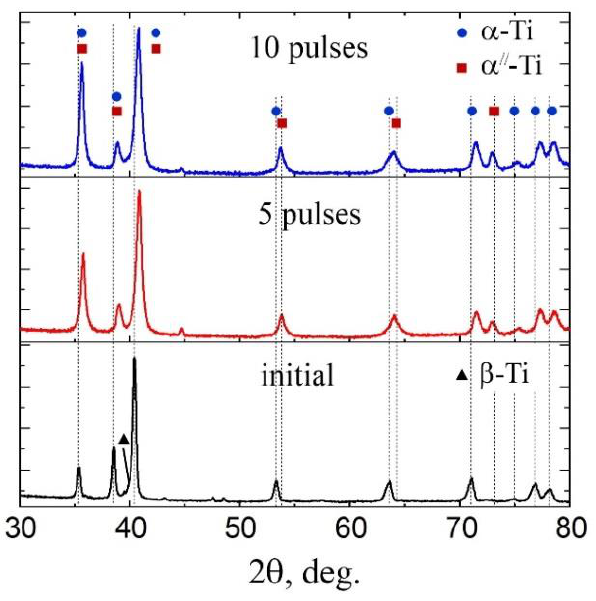
Figure 6. X-ray diffraction (XRD) patterns of the initial (as-built) sample and samples after PIB exposure.